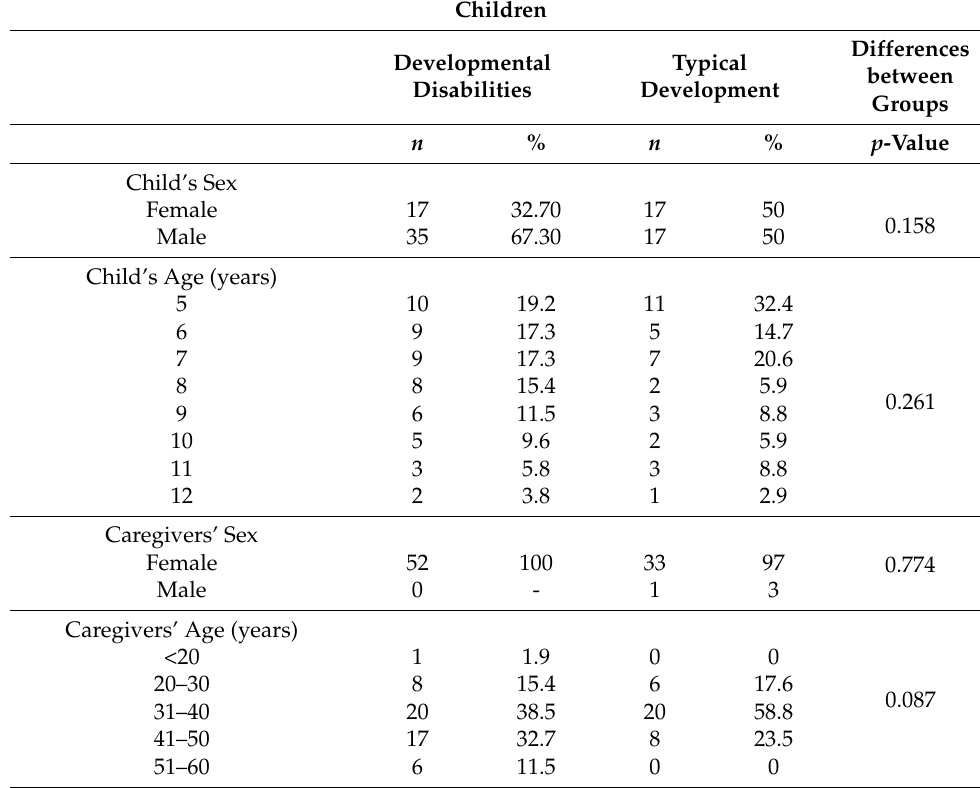
Table 1. Characteristics of the sample of children with DD and TD and test of the difference between groups.